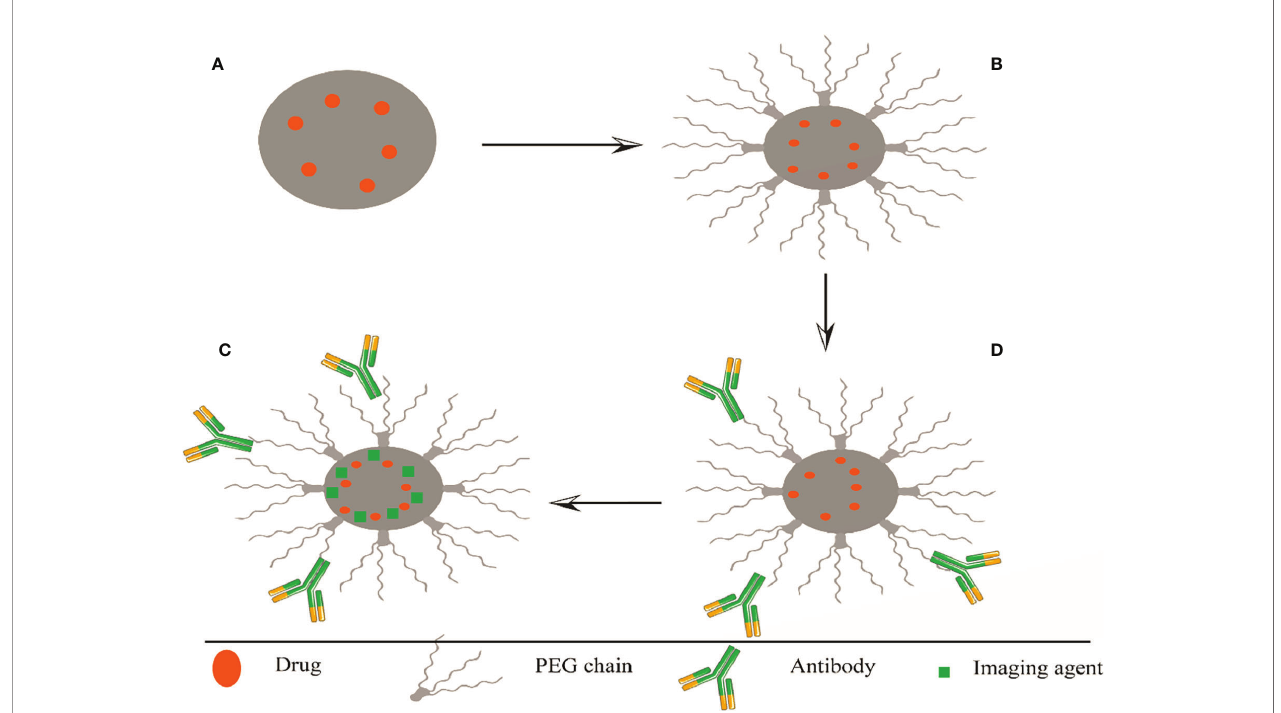
FIGURE 2 | Representation of several methods of surface modi fi cations of PLGA, (A) nanosphere and (B) PEGylated PLGA. Polyethylene glycol is a non-ionic and hydrophilic polymer; binding to the PLGA surface increases its half-life in the blood circulation. (C) Targeted PLGA, increased cell binding and selective internalization through receptor-mediated endocytosis. Target ligands often bind to PEG chains at the nanoparticle surface. The ligands must be optimally conjugated to the nanoparticles to maintain their combined af fi nity for receptor binding. (D) Theragnostics PLGA, load the drug with a fl uorescent traceable substance that can detect PLGA. PEG, Polyethylene glycol; PLGA, poly (lactide